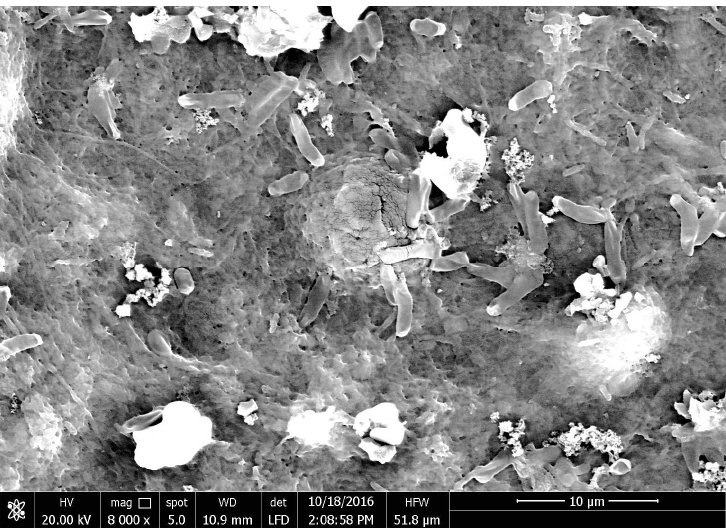
Figure 8. SEM image of oven-dried CNF/AC membrane after filtration of E. coli bacteria suspension.